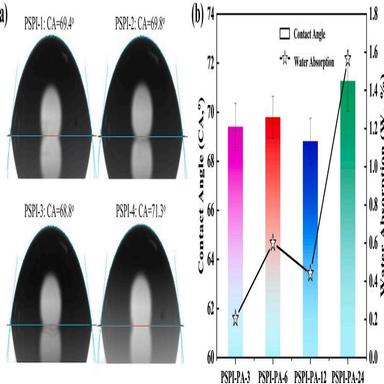
(a) The contact angle tests, and (b) the data of contact angel and water absorption of the PSPI.